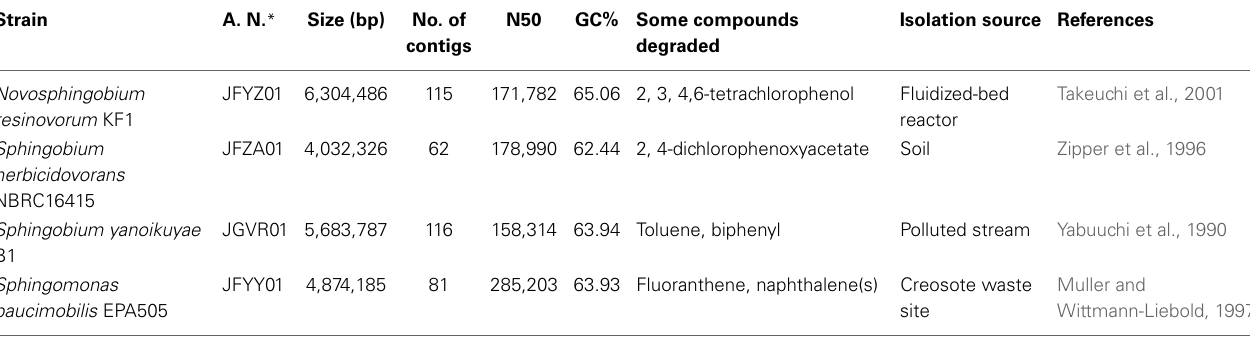
Table 1 | Strain information, genome assembly and annotation statistics of the sequenced sphingomonads used in this study. Strain